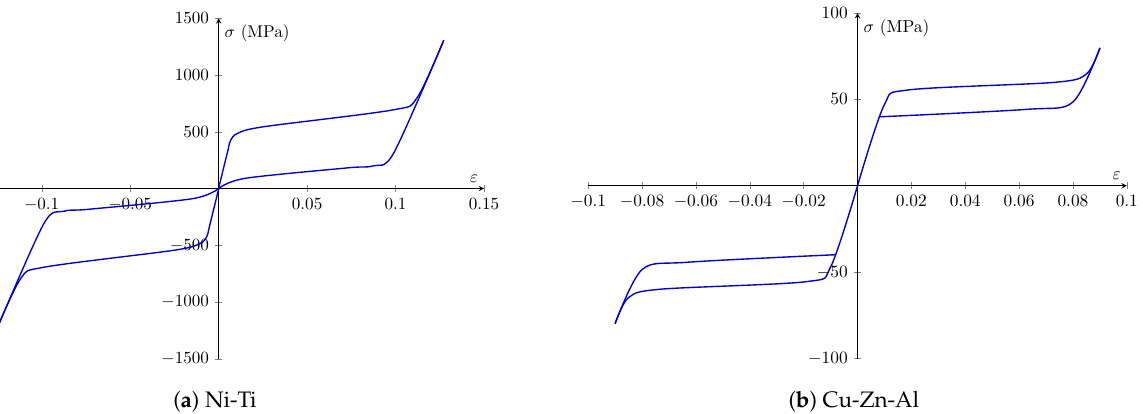
Figure 10. Numerical stress–strain curves of the SMA materials used in this study: ( a ) Ni-Ti and ( b )